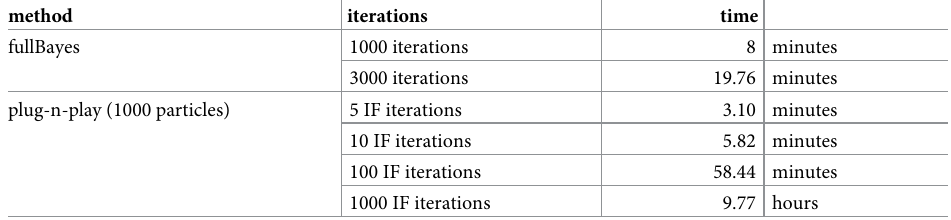
Table 3. Computational time for the SEIR model for one data set (IF: Iterated filtering